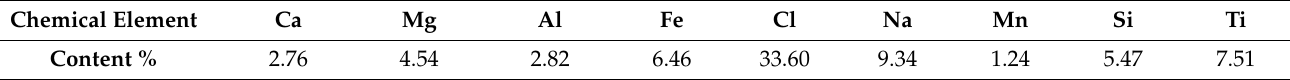
Figure 1. Molten salt chloride slags. Table 2. The main chemical composition of the molten salt chloride slag.